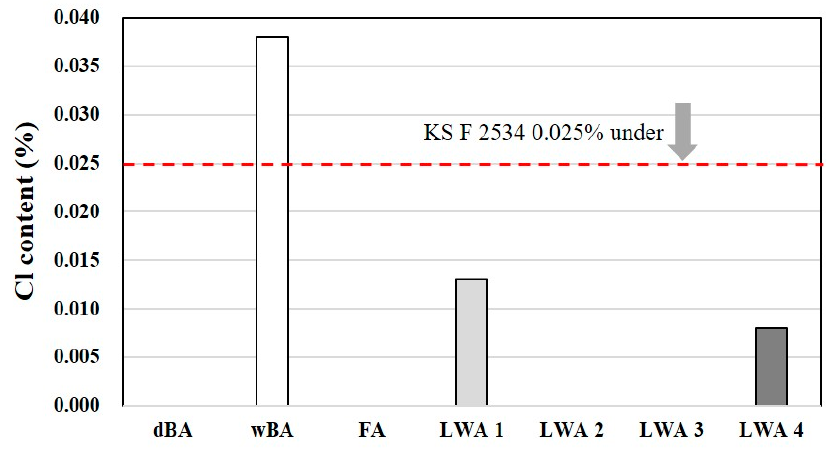
Figure 11. Cl contents of the test materials.